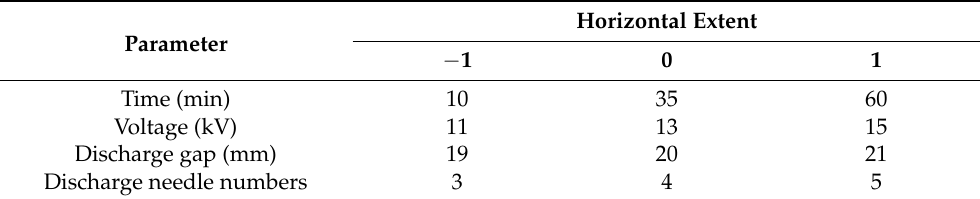
Table 1. Response surface factor level table in novel plasma